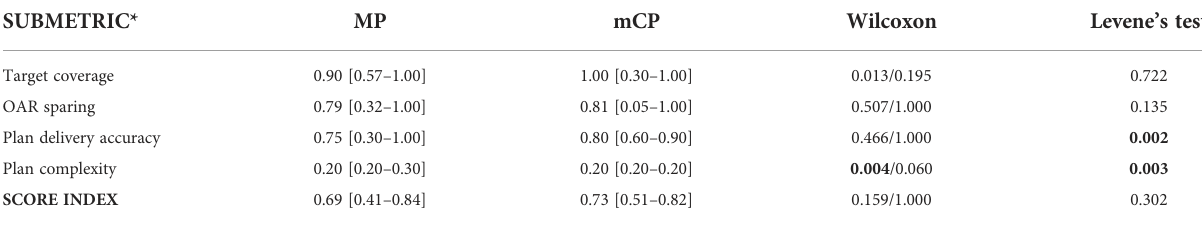
TABLE 4 Comparison of plan scoring index and its sub-metrics for plans and mCycle plans. Median values and ranges are reported. SUBMETRIC*